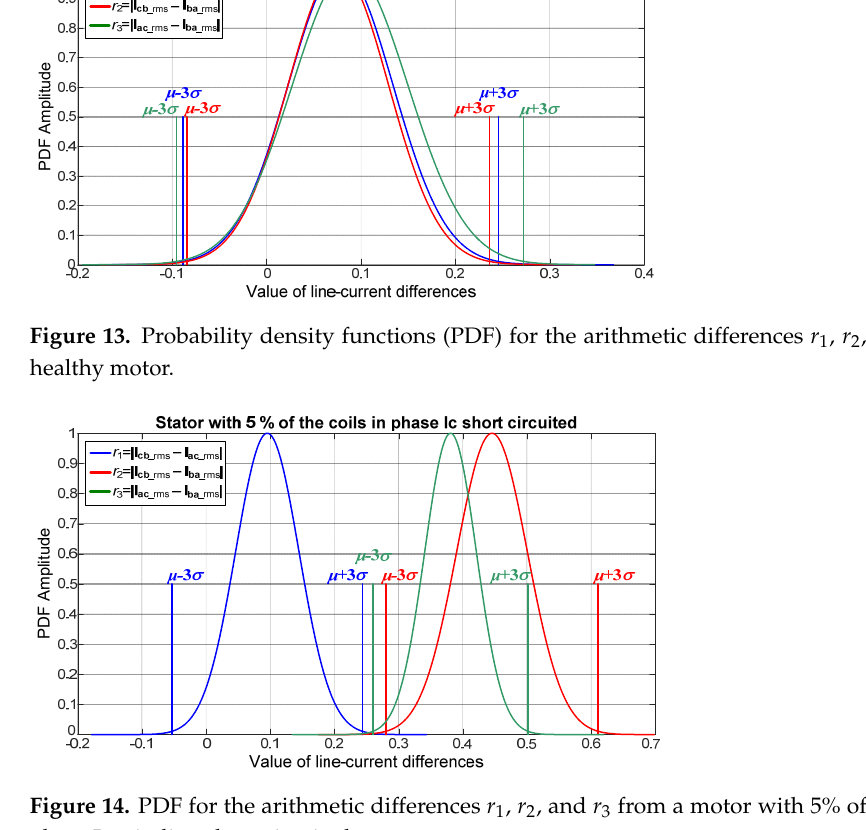
Figure 15. PDF for the arithmetic differences r 1 , r 2 , and r 3 from a motor with 12% of the coils in its phase I c winding short-circuited. From Figure 13, it can be observed that for a healthy motor, the three line current differences r 1 , r 2 and r 3 have very similar probability density functions; however, as the short-circuit fault appears and increases from 5% to 12% in the coils in the phase I c wind- ing, the mean ( μ ) and standard deviation ( σ ) of the line current differences r 2 and r 3 change and separate from the mean ( μ ) and standard deviation ( σ ) of the line current difference r 1 , as depicted in Figures 14 and 15, endorsing the utilization of the linguistic fuzzy rules defined in (7) for detecting and locating the short-circuit fault automatically.